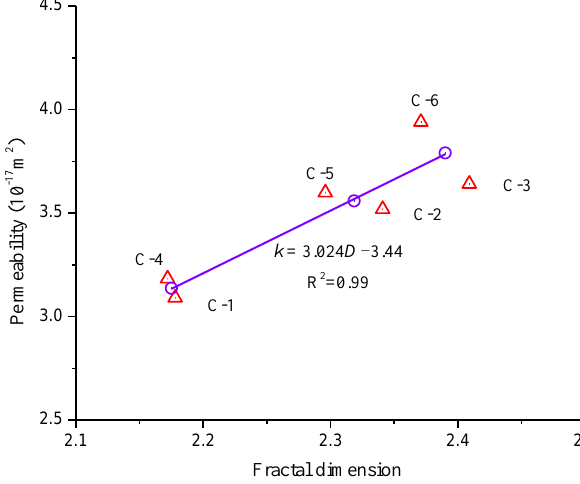
Figure 15. Relationship between the permeability and fractal dimension of fractured coal with different mining paths.